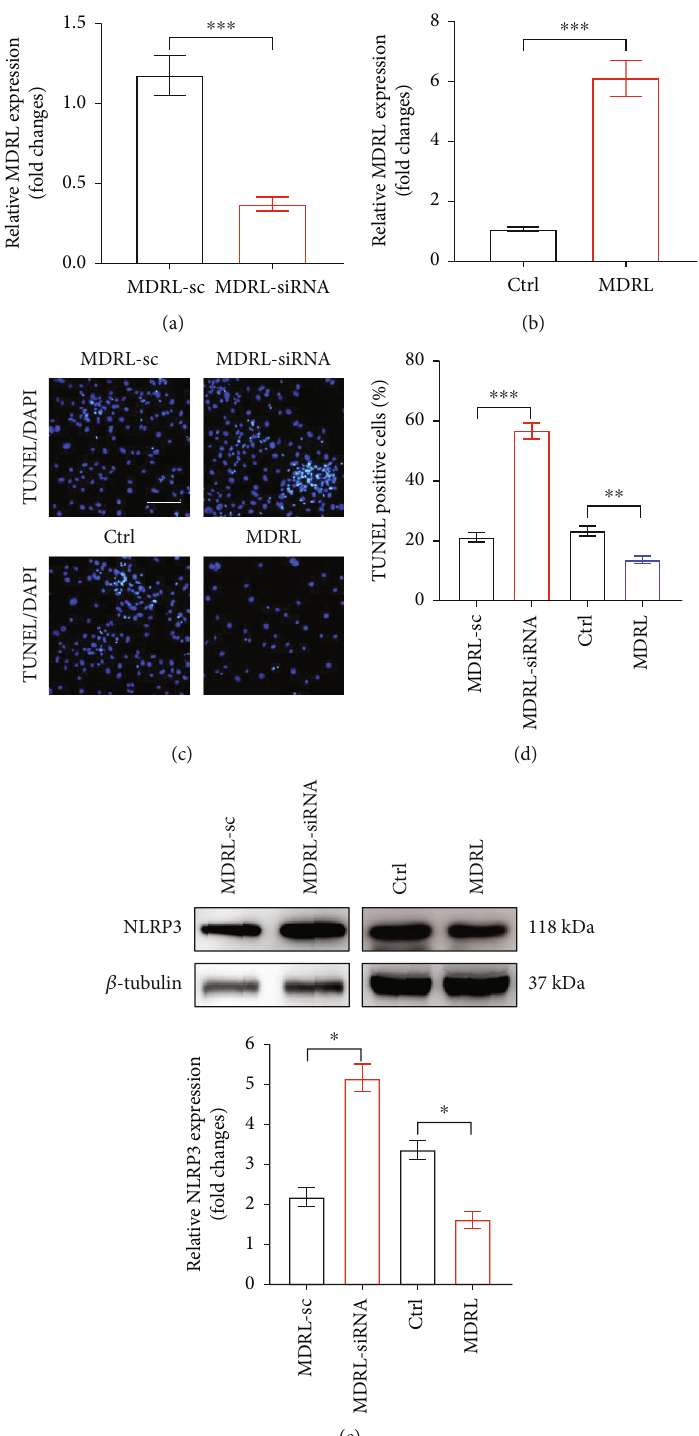
Figure 4: MDRL regulates NLRP3 in fl ammasome and apoptosis in VSMCs. (a) The expression of MDRL in MSMCs transfected with siRNA (MDRL-siRNA) or scramble (MDRL-sc) were analyzed by qRT-PCR. (b) The expression of MDRL in MSMCs transfected with adenoviral MDRL (MDRL) or control adenovirus (ctrl) was analyzed by qRT-PCR. (c) Representative images of TUNEL staining in MSMCs transfected with MDRL-sc, MDRL-siRNA, ctrl, or MDRL. Scale bar: 50 μ m. (d) Quanti fi cation of TUNEL-positive cells in MSMCs in the indicated groups. (e) Western blots showed the expression levels of NLRP3 in MSMCs in the indicated groups and quanti fi cation. The relative expression of NLRP3 was normalized to housekeeping gene β -tubulin in corresponding lane. Data are presented as mean ± SEM. ∗ P < 0 : 05 , ∗∗ P < 0 : 01 , ∗∗∗ P < 0 : 001 vs MDRL-sc or ctrl